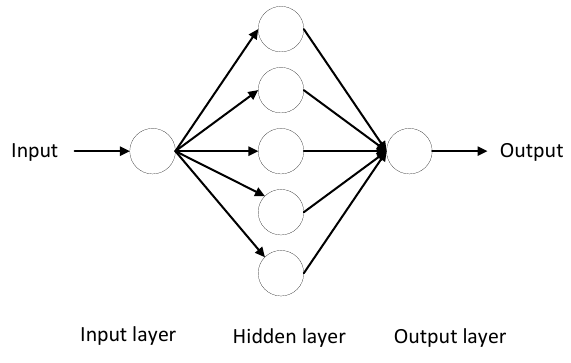
Figure 3. Structure of neural